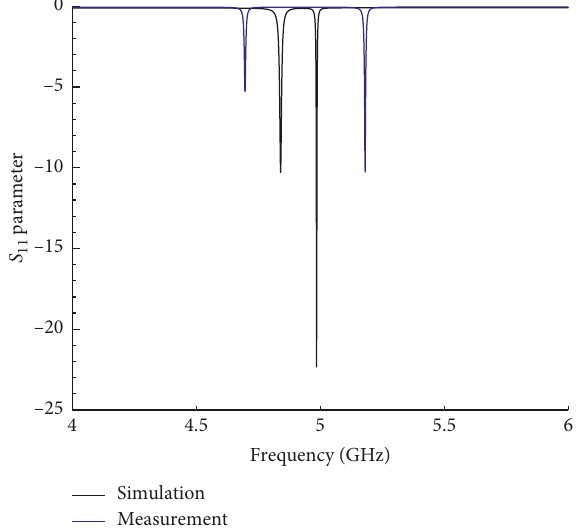
Figure 13: Measured and simulated group delay corresponding to the third proposed resonator (structure